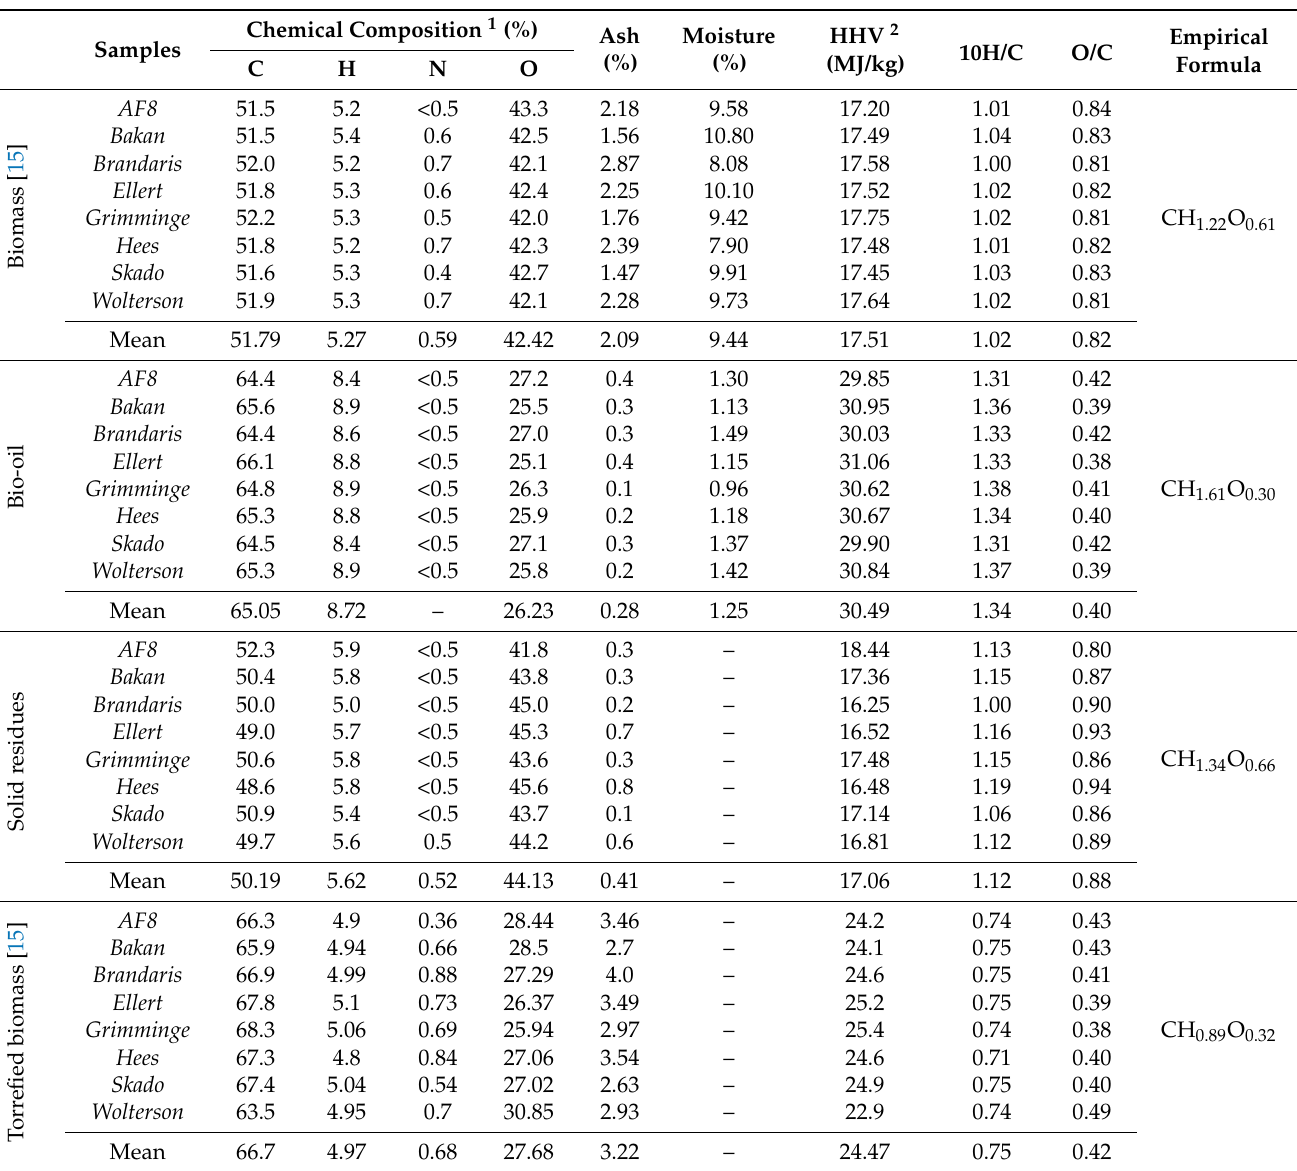
Table 2. Chemical characterization of poplar clones, bio-oils, solid residues, and torrefied